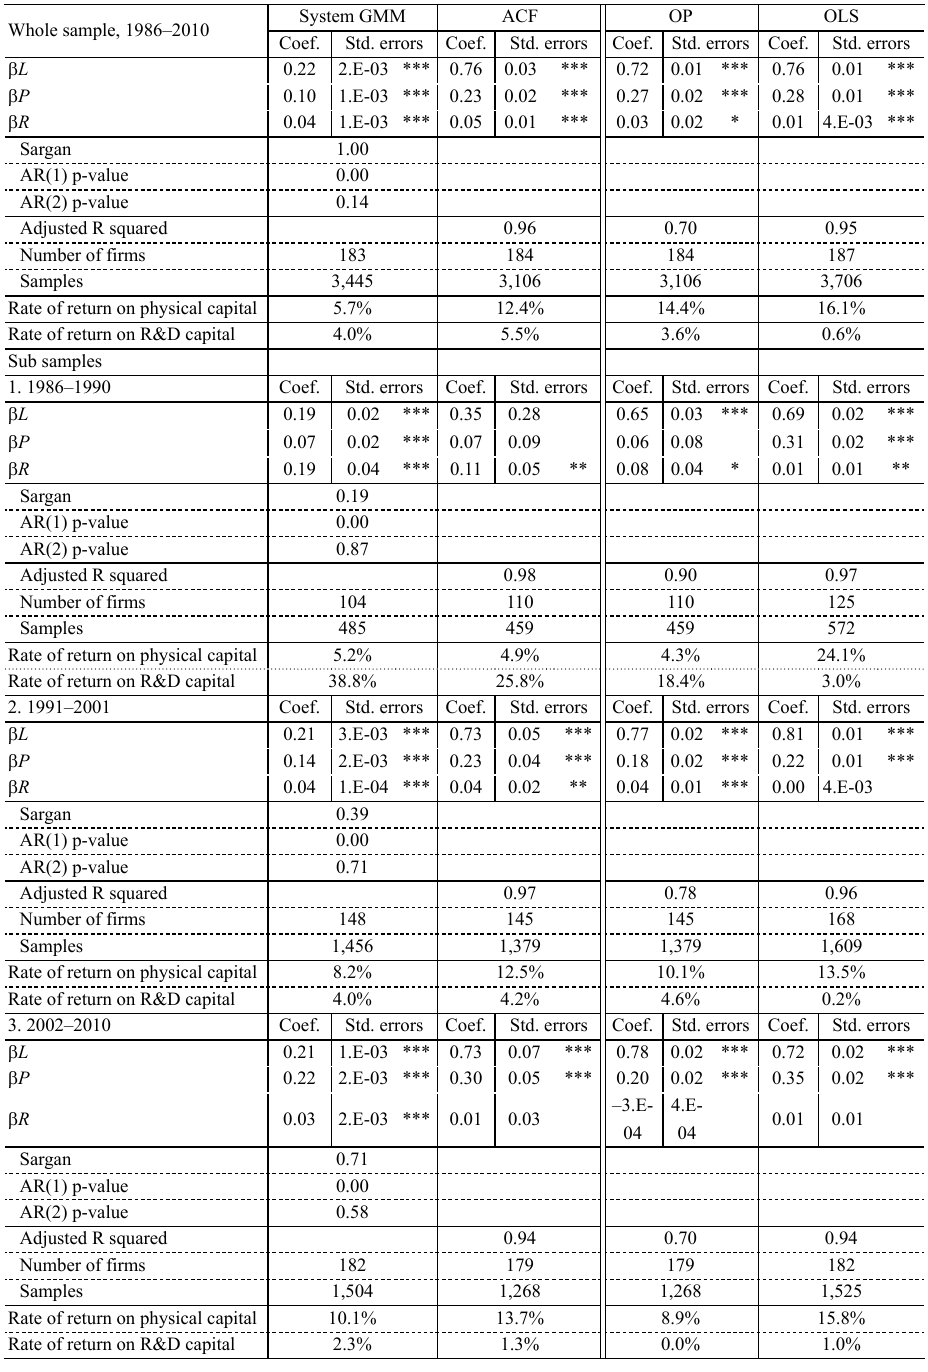
Table 6. Comparison of results from the four estimation methods for chemical firms Whole sample,